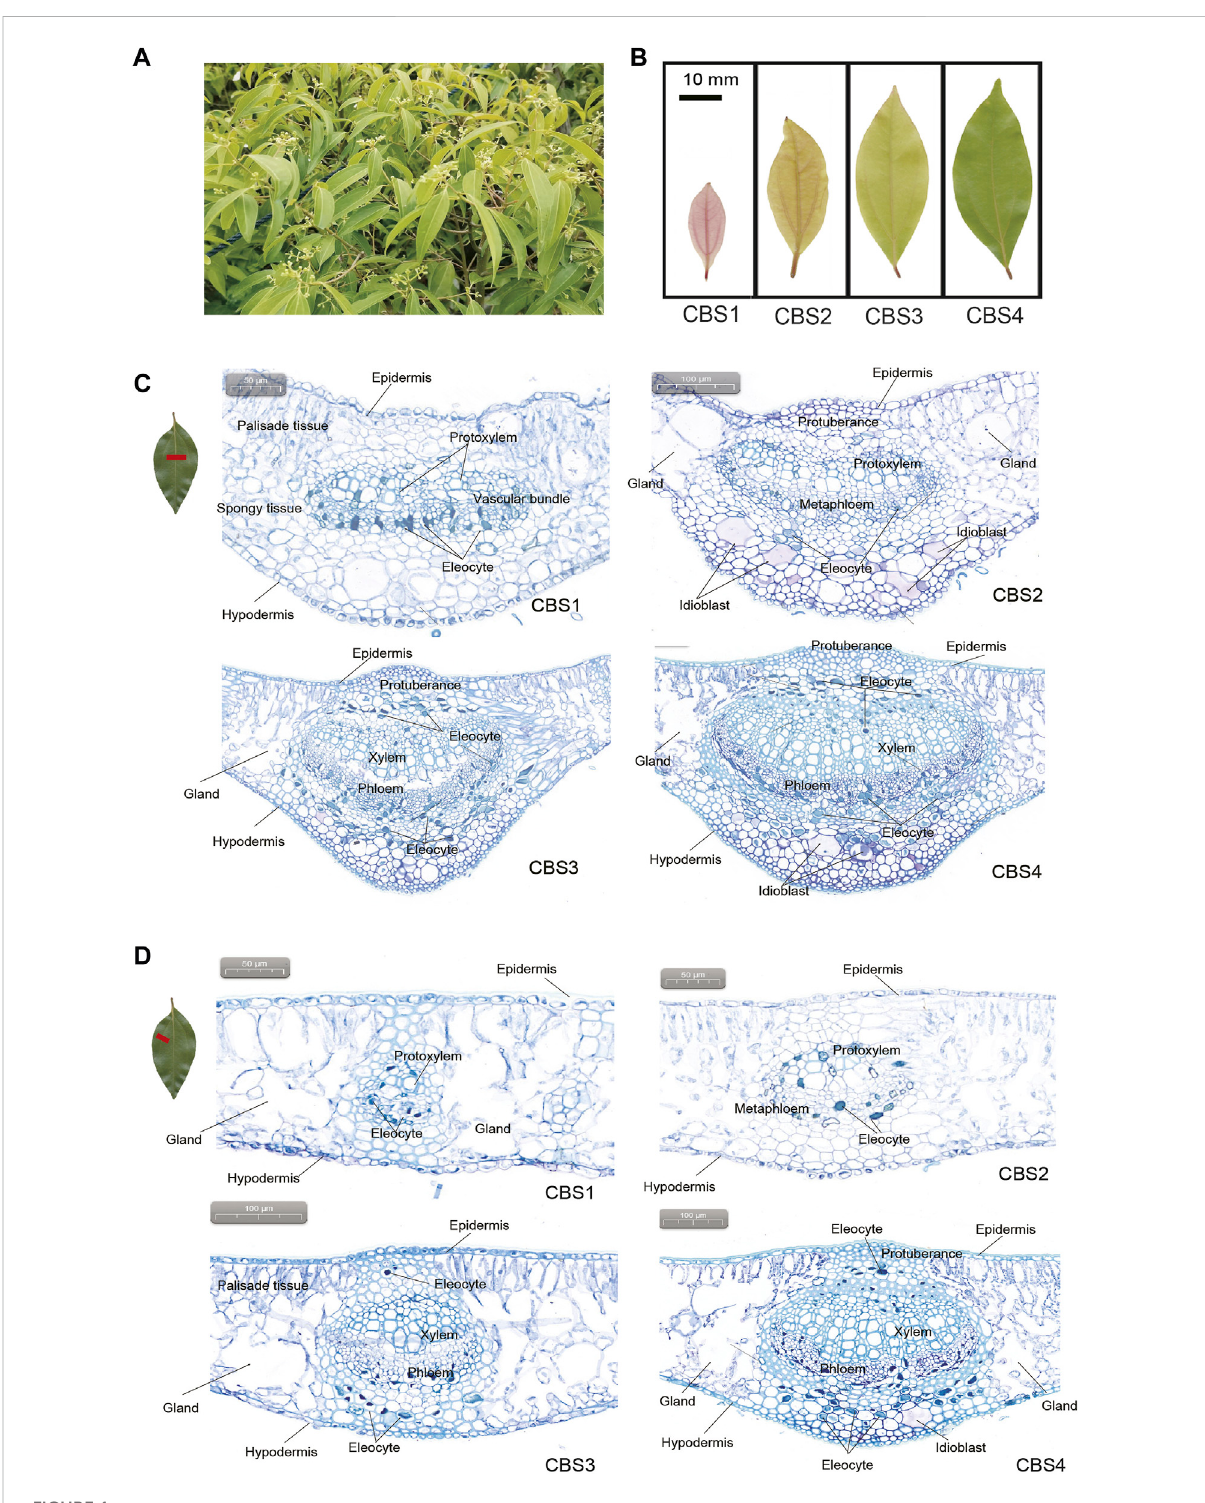
FIGURE 1 Gross morphology and anatomy of Cinnamomum burmannii leaves. (A) Six-year-old C. burmannii plant. (B) Leaves at four developmental stages (CBS1 ‒ CBS4). (C) Anatomy and histology of the main vein of C. burmannii leaves at four developmental stages. (D) Anatomy and histology of the lateral vein of C. burmannii leaves at four developmental